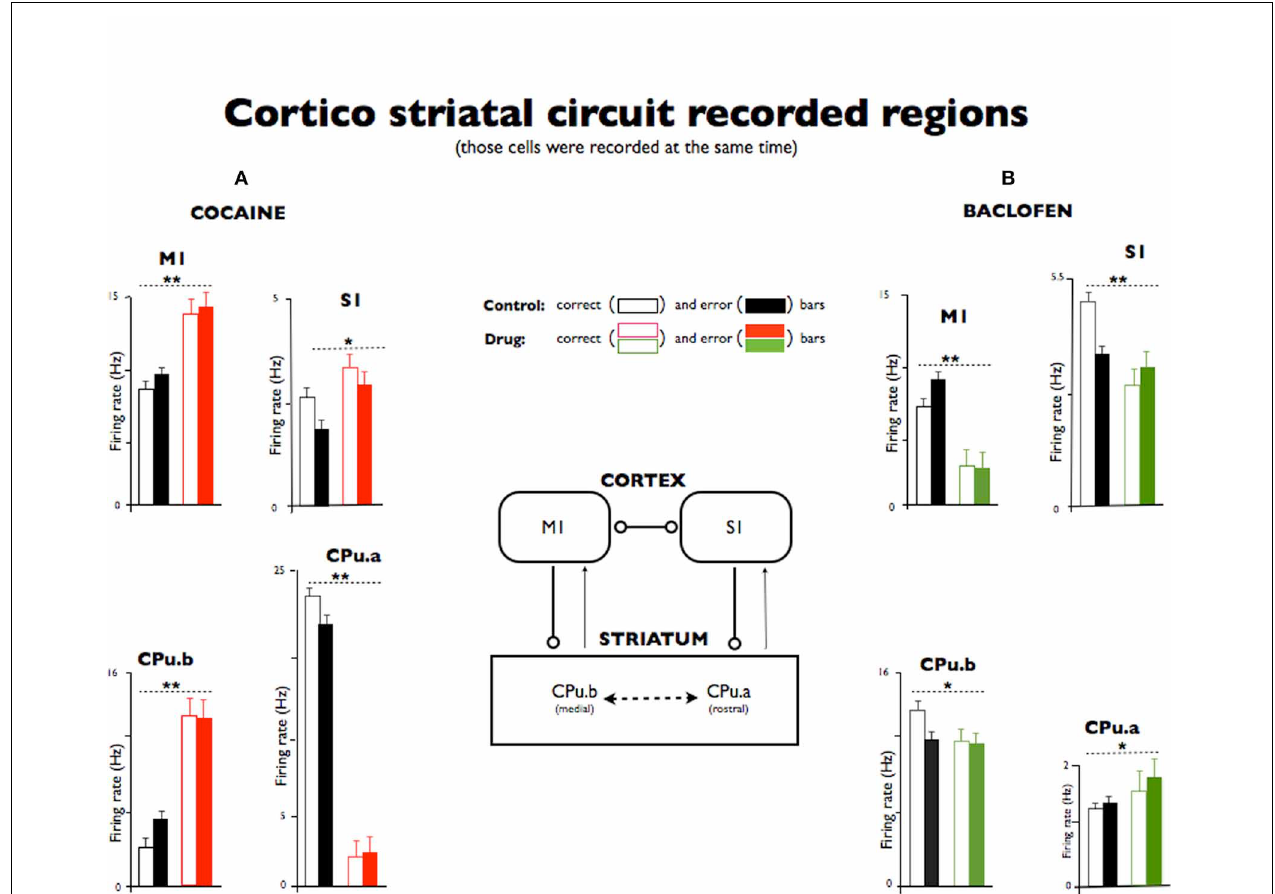
FIGURE 3 | Simultaneous recorded neurons in sensory and motor cortices and striatum under different task conditions and following cocaine and baclofen administration. (A) Cortex (S1, M1) and striatal (CPu.a and CPu.b) neuron firing rates during correct vs. error responses (open and black filled bars) recorded in control (saline) vs. cocaine treated trials (red open and red filled bars). Cocaine strongly increased the firing rate in the motor cortex and in the striatal medial segment (M1, CPu.b) and to a lesser degree in S1, and strongly depressed activity in rostral striatal neurons (CPu.a). (B) Neurons recorded in the same four areas from another animal in